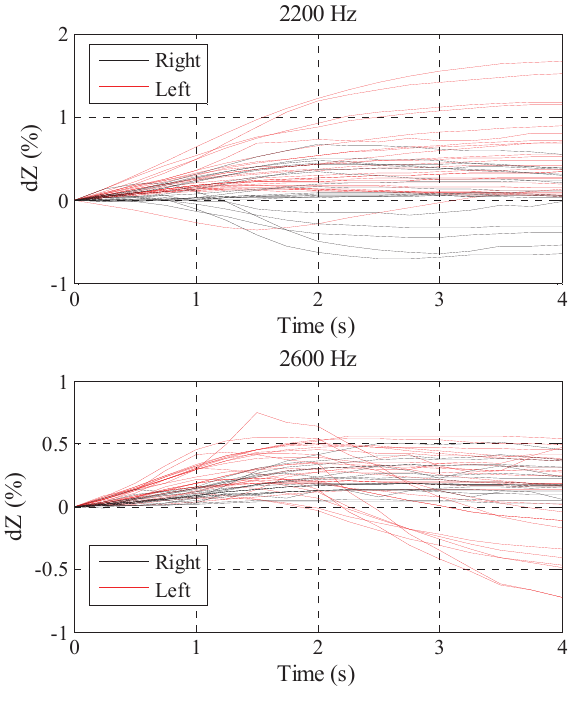
Fig. 7: dZ values recorded at 2.2 kHz and 2.6 kHz during a single seizure. Seizure onset is at t = 0. Right and left refers to the site of electrode